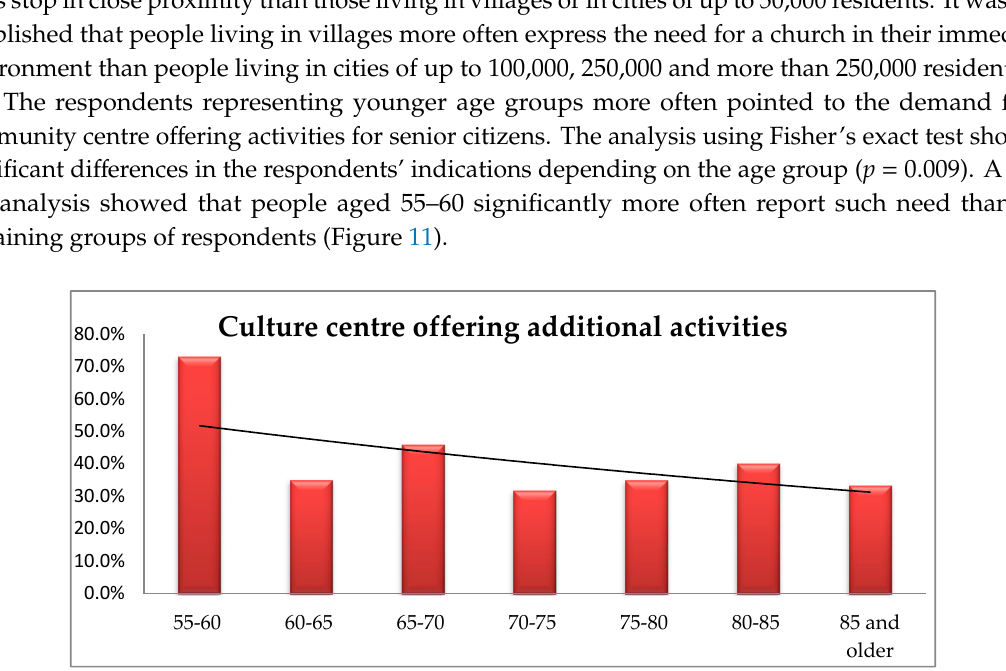
Figure 11. The respondents’ age vs. their opinion about the presence of a culture centre offering additional activities in their immediate environment.